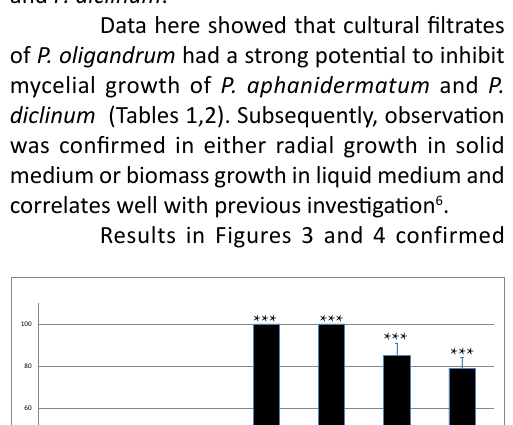
1 Control = Full strength – 50 mg V-8 agar medium; 2 Quarter strength = 12.5 ml filtrate + 37.5 ml V-8 agar medium 3 Half strength = 25 ml filtrate + 25 ml V-8 agar medium; 4 Mycelia dry weight growth was determined by weighting mycelial dry weight after 8 days and taking the average. Data are the mean of six reads + standard errors. **, *** Data are the mean of three replicates and reflect differences between averages of the samples compared to the control sample. Significant values against control represent: ** = highly significant at p < 0.01, *** = very significant at p < 0.001.